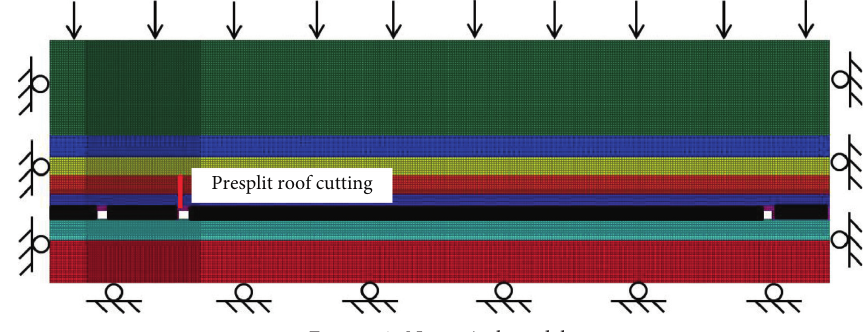
Figure 9: Numerical model.